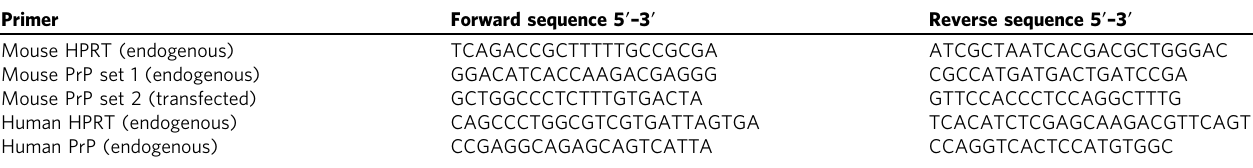
Table 1 Primers employed to amplify endogenous and transgenic